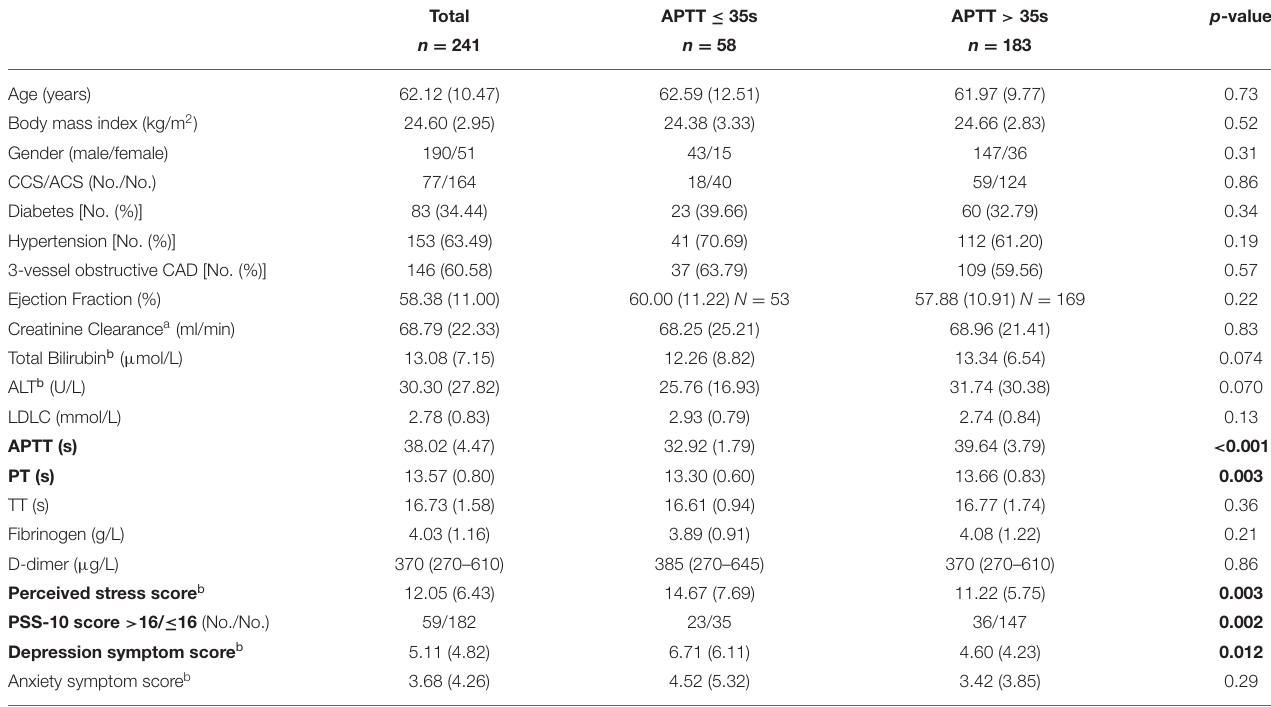
TABLE 2 | Comparisons of the baseline characteristics between the groups categorized by activated partial thromboplastin time (APTT).